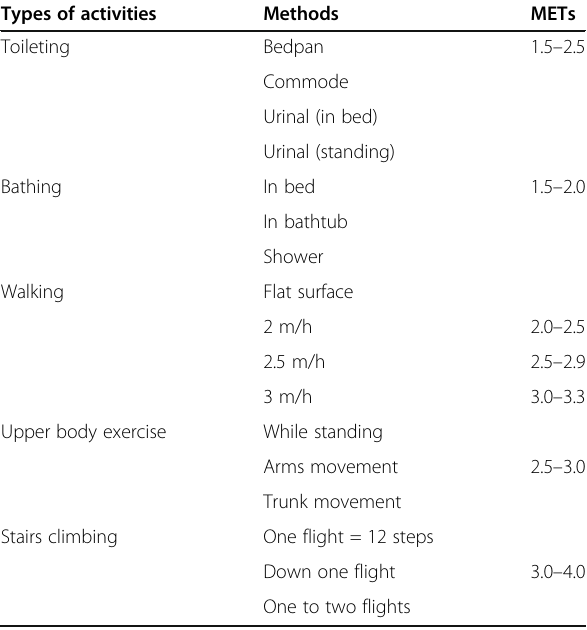
Table 2 Types of activities commonly used in early